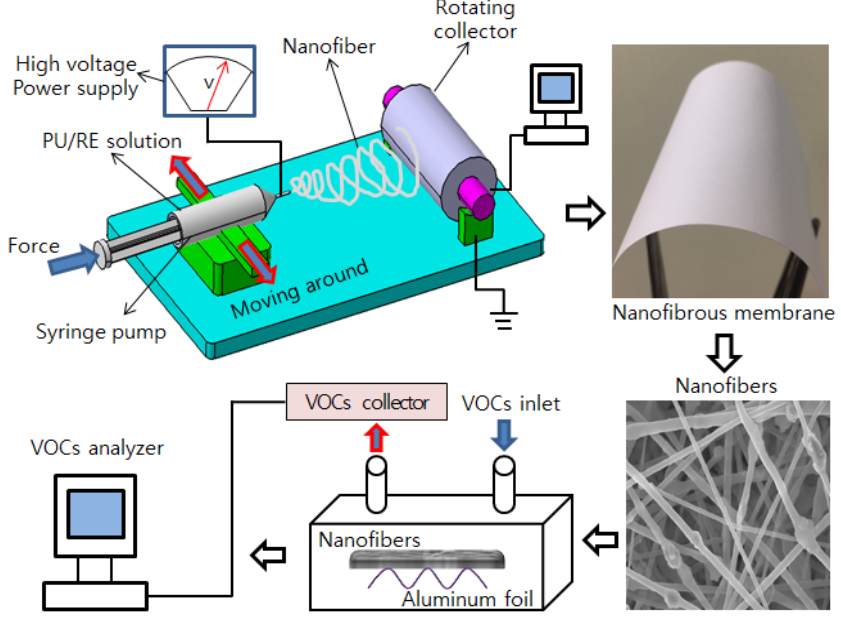
Figure 1. Schematic diagram of the electrospinning setup and volatile organic compounds (VOCs) absorption experiment.